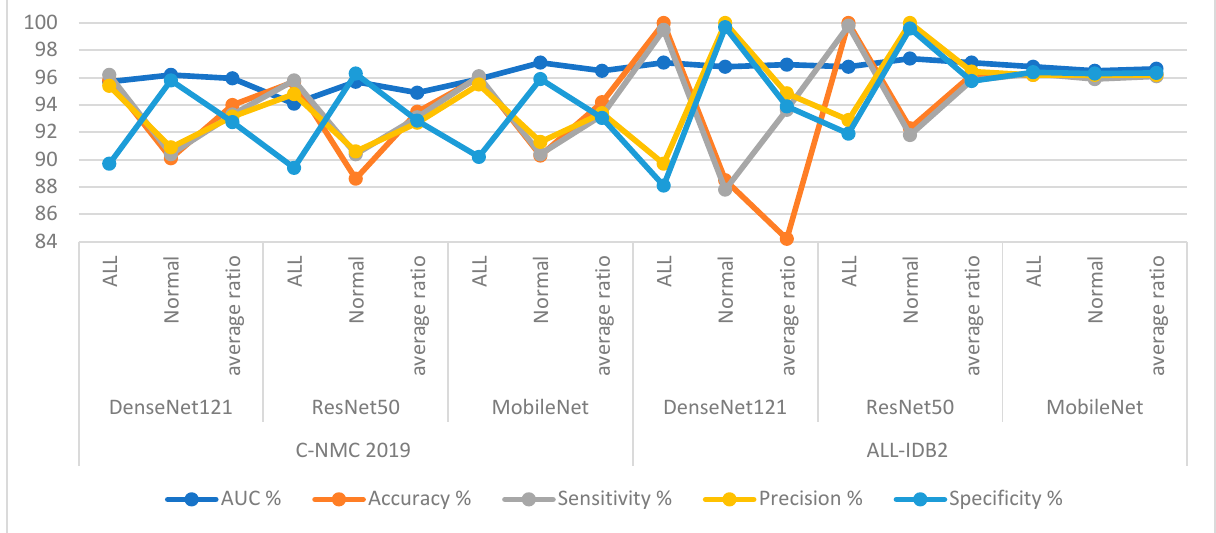
Figure 8. Display of results of CNN models based on WBC segmentation of the C-NMC 2019 and ALL-IDB2 datasets for acute leukemia diagnosis.